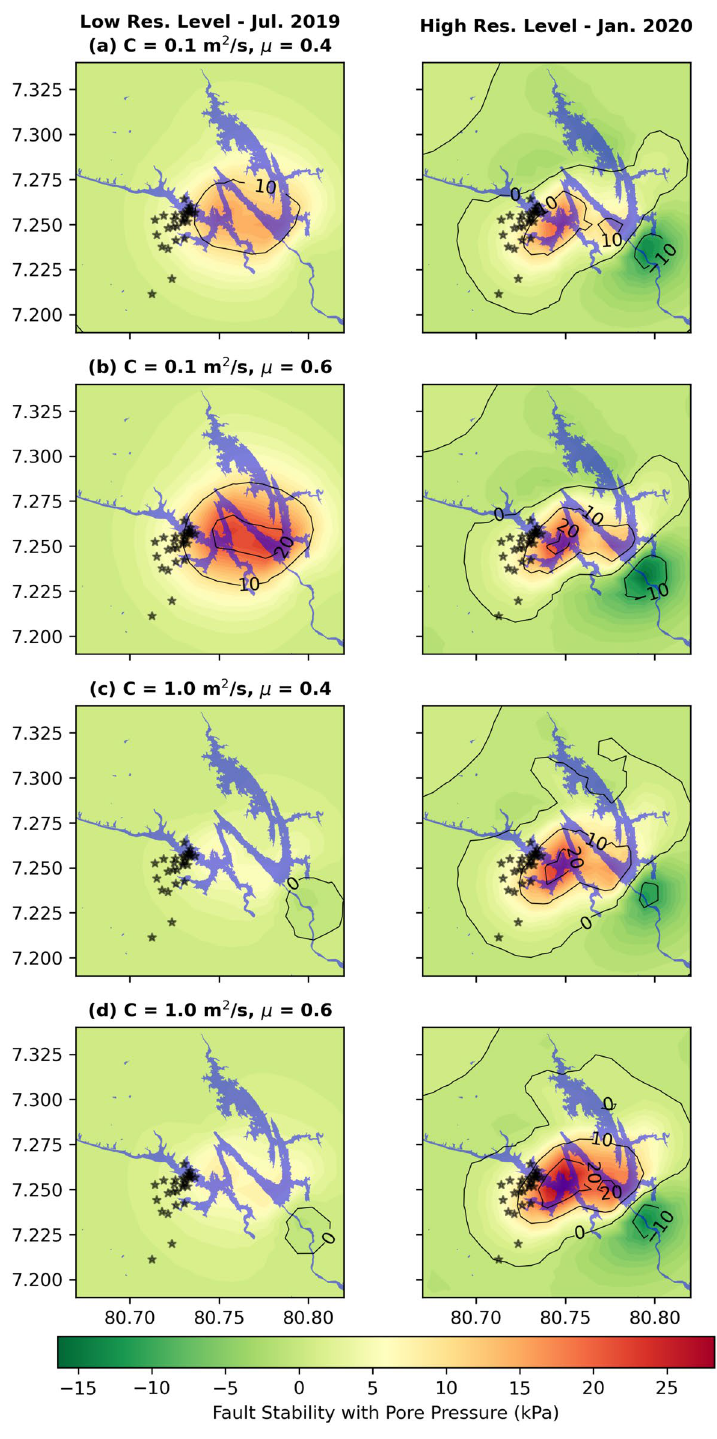
Figure 4. Spatial variation of change in fault stability. ( a – d ) Spatial stability of the fault plane striking 265° of the largest earthquake on 29 August 2020 earthquake with pore-pressure for diffusivities (C) of 0.1, 1.0 m 2 /s and coefficients of friction (μ) of 0.4, 0.6 at the low reservoir level (left column) in July 2019 and high reservoir level (right column) in January 2020 at a depth of 2 km (see Fig. 3 for reservoir level time series). Note the increase in fault stability when the reservoir level is high in January 2020. Black stars are earthquake epicentres in Supplementary Table S1. Blue coloured region is the Victoria Reservoir. Figure made with Python Matplotlib 62